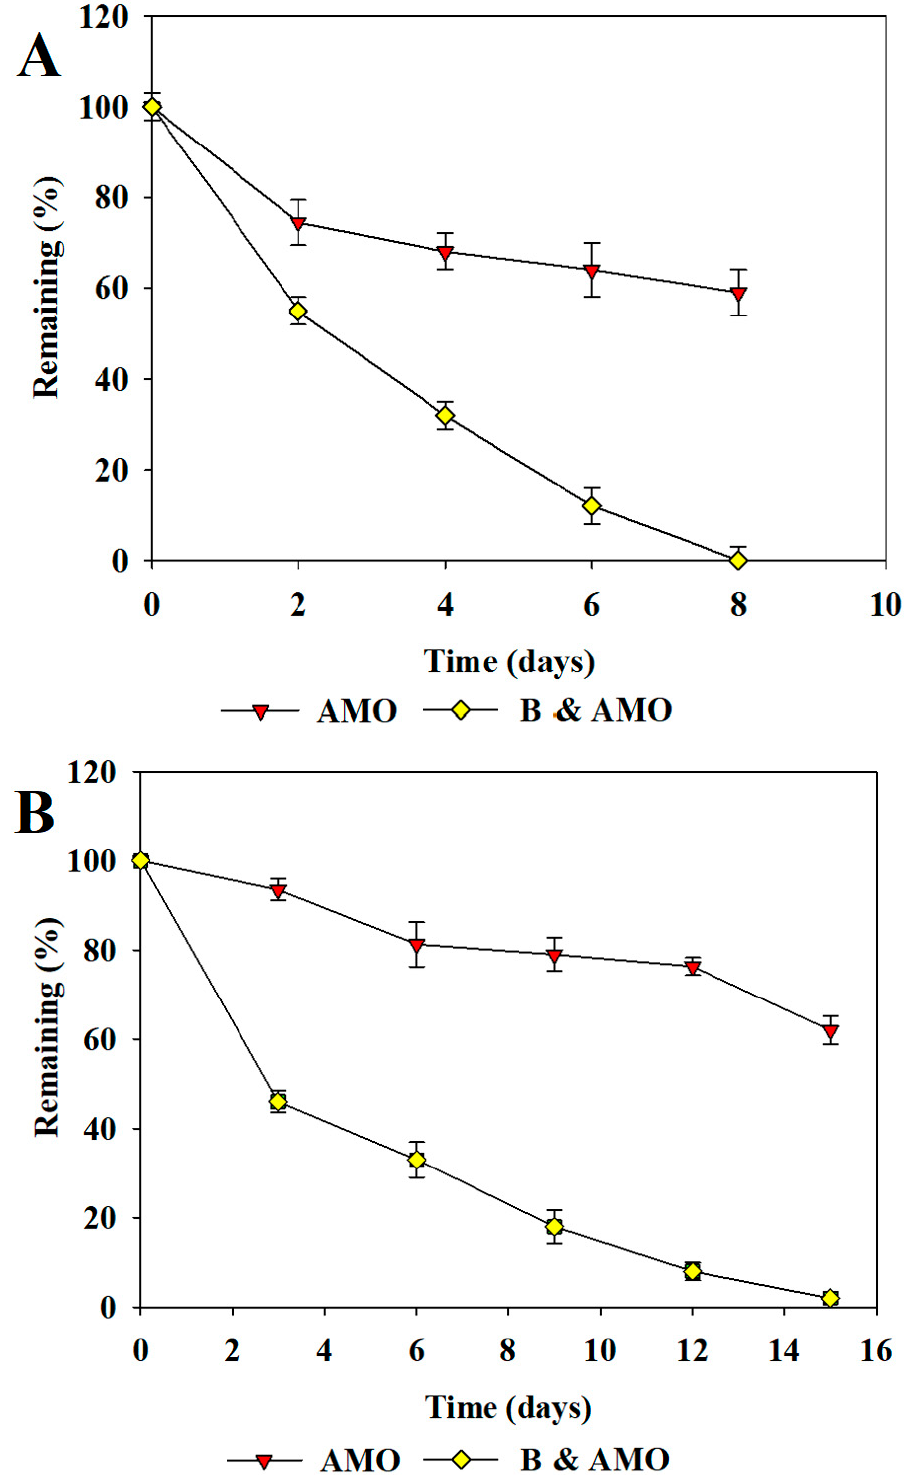
Figure 5. Degradation of amoxicillin with and without degrading bacteria in sludge. Aerobic ( A ) and anaerobic ( B ) degradation of AMO. AMO: amoxicillin. B: isolated antibiotic-degrading bacteria. Data from three independent experiments are presented as the means ± SE.